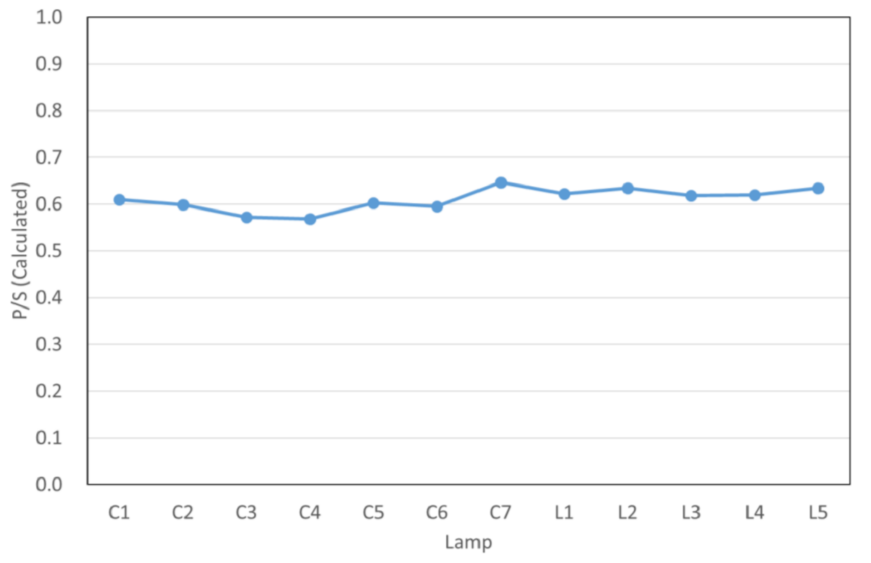
Figure 2. Energy e ffi ciency value calculated of each